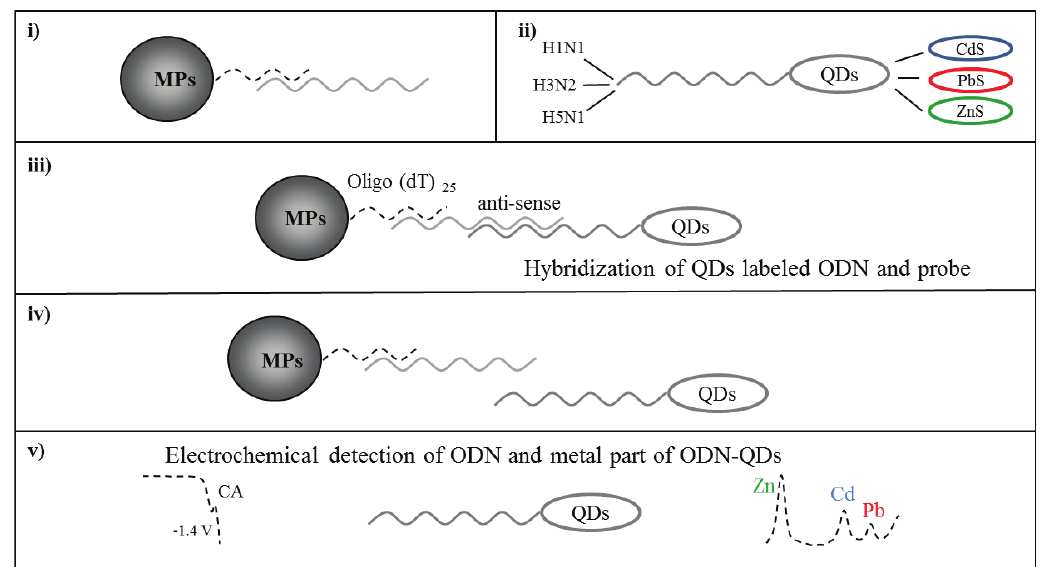
Figure 1. Scheme of fully automated paramagnetic particles (MPs)-based isolation followed by electrochemical detection of target ODN labeled with QDs. As a target, three different ODNs derived from point-mutated neuraminidase gene of influenza H5N1 were used. ( i ) Covalent binding between oligo (dT) and anti-sense sequence of different 25 H5N1-derived ODNs; ( ii ) Target influenza ODNs labeled with QDs (China ODN with CdS, Aichi with PbS and Zhejiang with ZnS); ( iii ) Hybridization between anti-sense sequence bound to MPs and target sequence labeled with QDs; ( iv ) Isolation of target sequence ODN-QDs and elution from MPs (elution temperature 85 °C); ( v ) Electrochemical detection of ODN-QDs complex, ODN (CA peak) was measured by adsorptive transfer technique coupled with square wave voltammetry (AdTS SWV) and metal part of QDs (Cd, Pb and Zn peak) was measured by differential pulse anodic stripping voltammetry